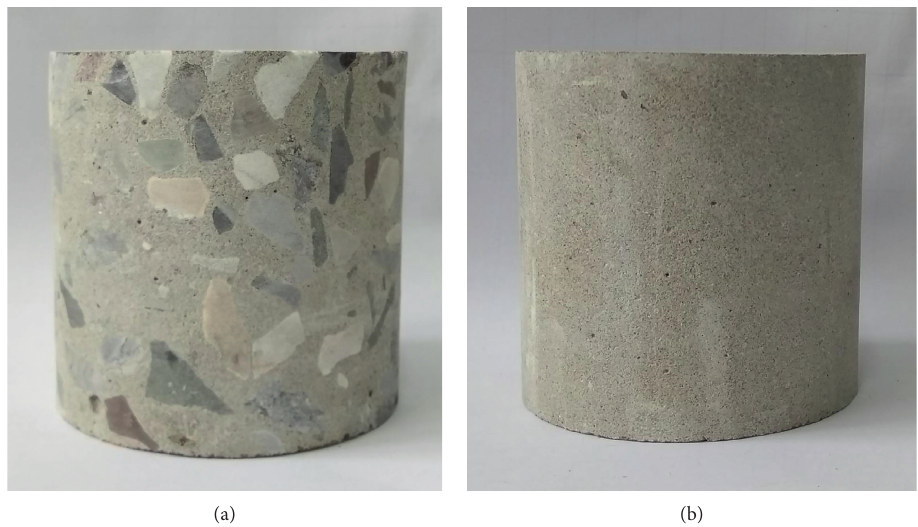
Figure 1: Specimens used for the SHPB testing. (a) Mortar. (b) Concrete.